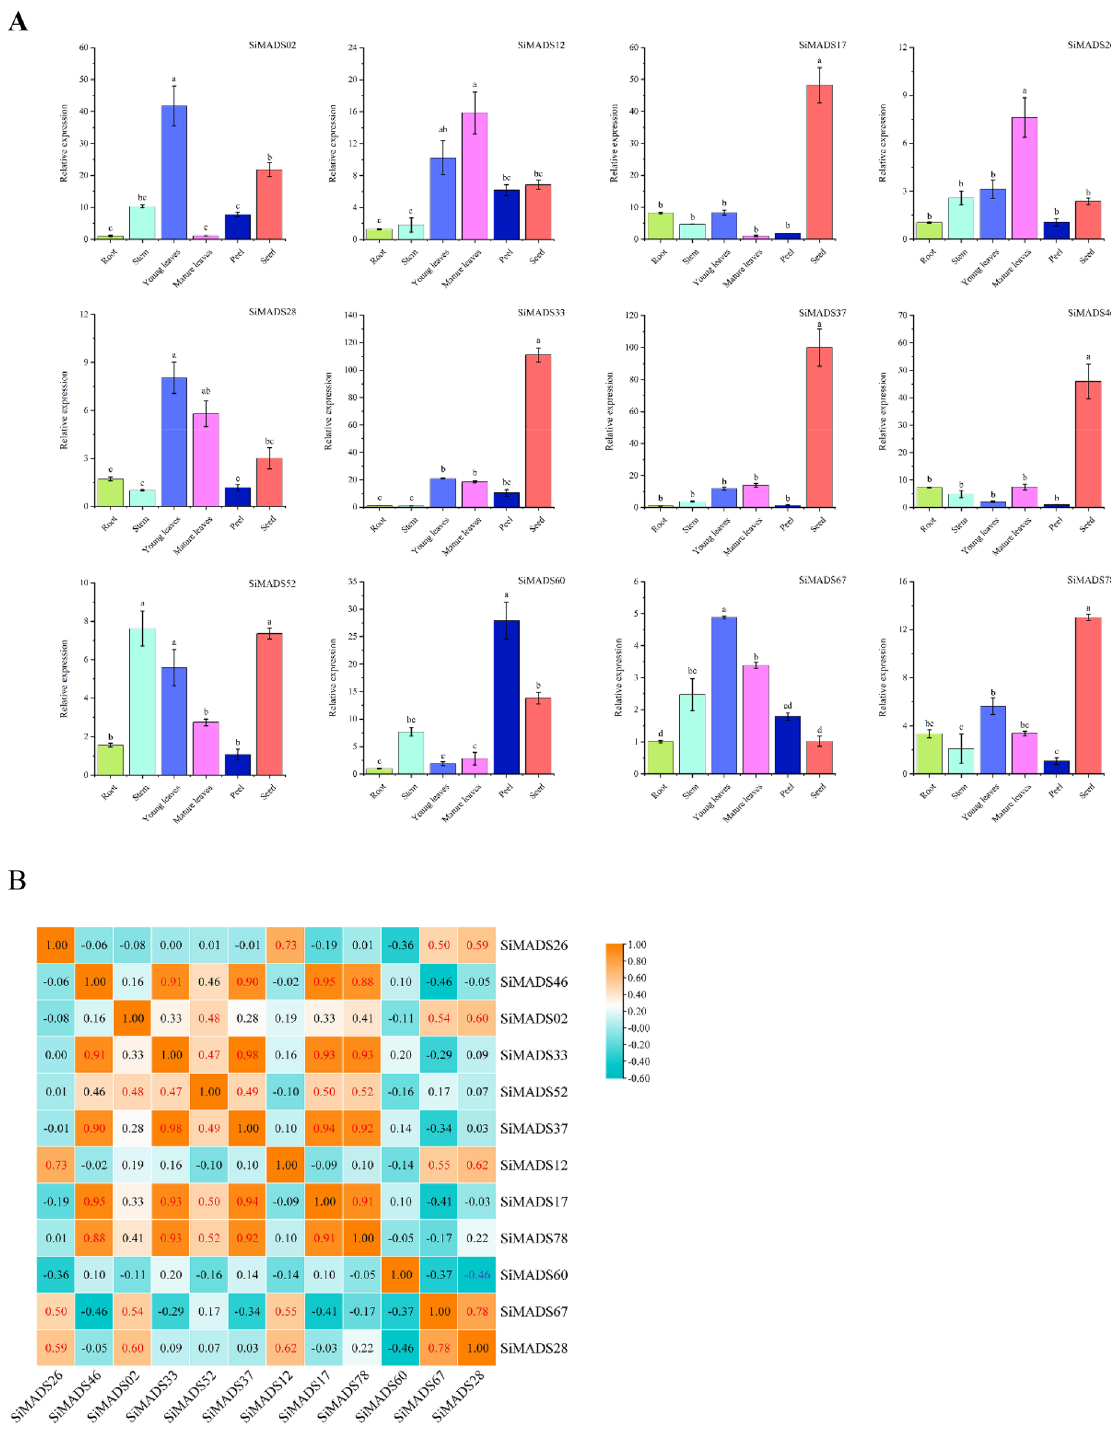
Figure 7. Tissue-specific expression of 12 S. italica MADS-box genes and their correlation with expression patterns in the middle stage of grain filling. ( A ) Expression patterns of 12 S. italica MADS-box genes in the root, stem, young leaves, mature leaves, peel and seed organs were examined by qRT-PCR. Error bars were obtained from three measurements. Lowercase letter above the bar indicates significant difference (α = 0.05, LSD) among treatments. ( B ) Positive number: positively correlated; negative number: negatively correlated. Red numbers indicate a significant correlation at the 0.05